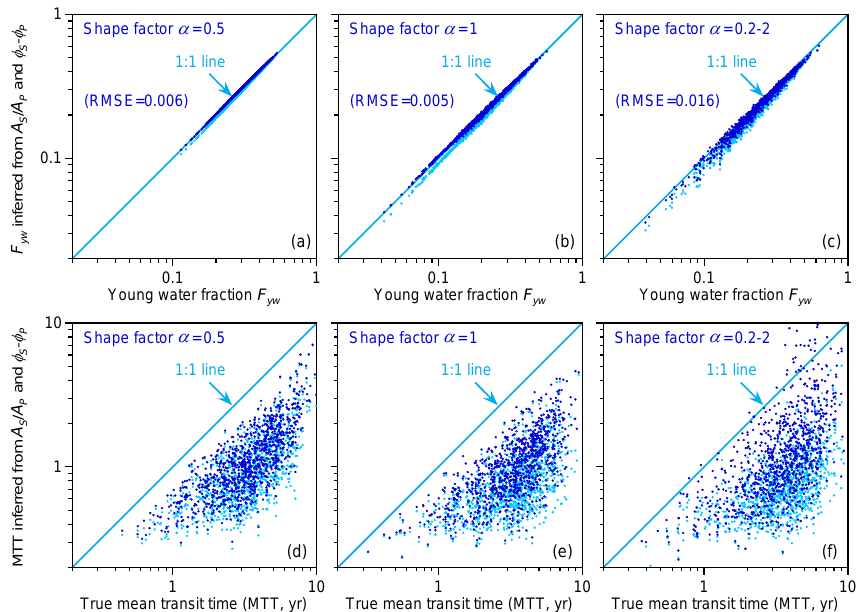
Figure 14. Effect of including phase information in estimates of young water fraction ( F yw ) and MTT. Light symbols show F yw and MTT estimates derived from tracer cycle amplitude ratios ( A S /A P ) alone; dark symbols show the same estimates derived from amplitude ratios and phase shifts ( ϕ S − ϕ P ). Data points come from the same 1000 synthetic catchments shown in Fig. 13, each consisting of eight subcatchments with randomly chosen mean transit times between 0.1 and 20 years. Adding phase shift information eliminates much of the (already small) bias in F yw estimates, particularly when F yw is small. Adding phase information reduces the bias in MTT estimates as well, but a severe underestimation bias